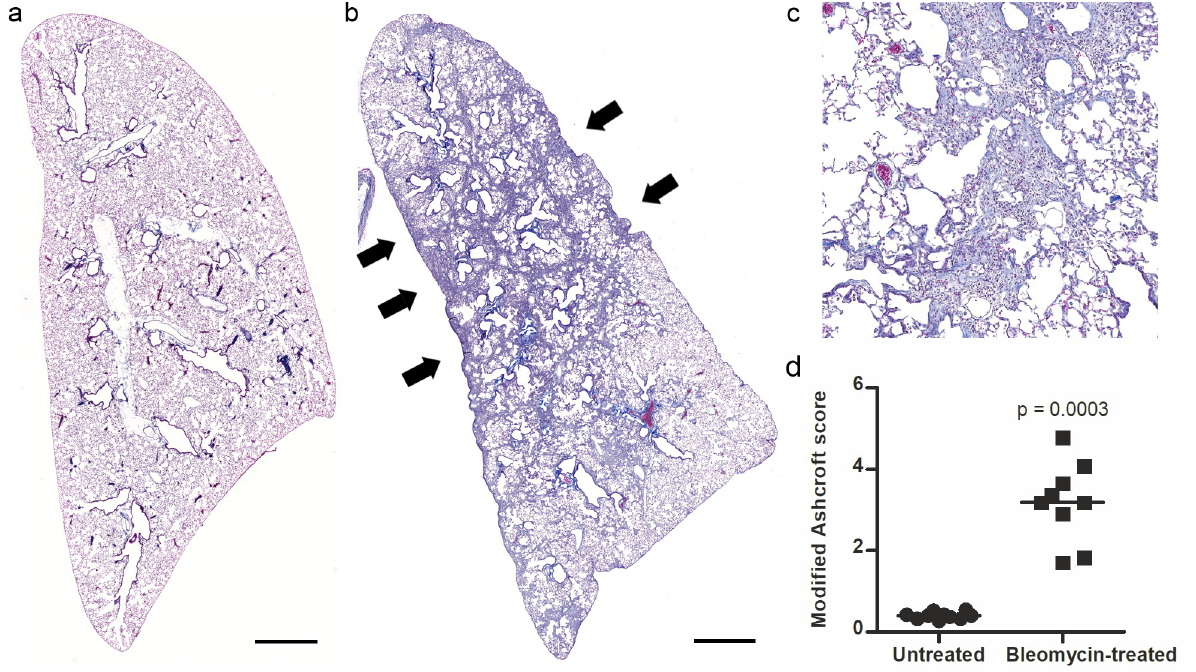
Fig 1. Lung fibrosis at 4 weeks after bleomycin administration. a) Masson’s trichrome staining of an untreated left lung and b) of a bleomycin- treated left lung. Fibrotic changes are indicated by arrows. Scale bars 1 mm. c) Example of a 0.9 mm wide close-up image of a bleomycin-treated lung produced by the random sampling procedure, with a modified Ashcroft score of 5. A nonlinear tone curve adjustment was applied to all images to correct white balance. d) Modified Ashcroft scores for the experimental groups, untreated (round symbols) and bleomycin-treated (square symbols). Lines at means. n = 9–10. Mann-Whitney U